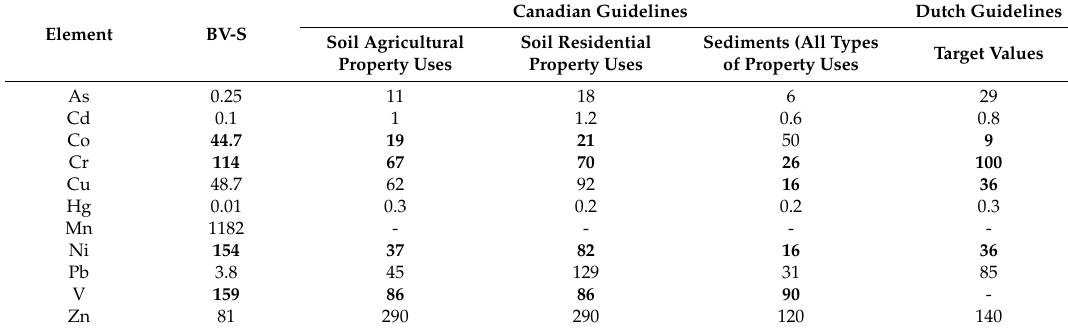
Table 3. Baseline values of PTE from the alluvial deposits of Santiago, and admissible levels (in mg kg − 1 ) in soils and stream sediments according to the Ontario (88) and Dutch guidelines (89). Canadian Guidelines Dutch Element BV-S